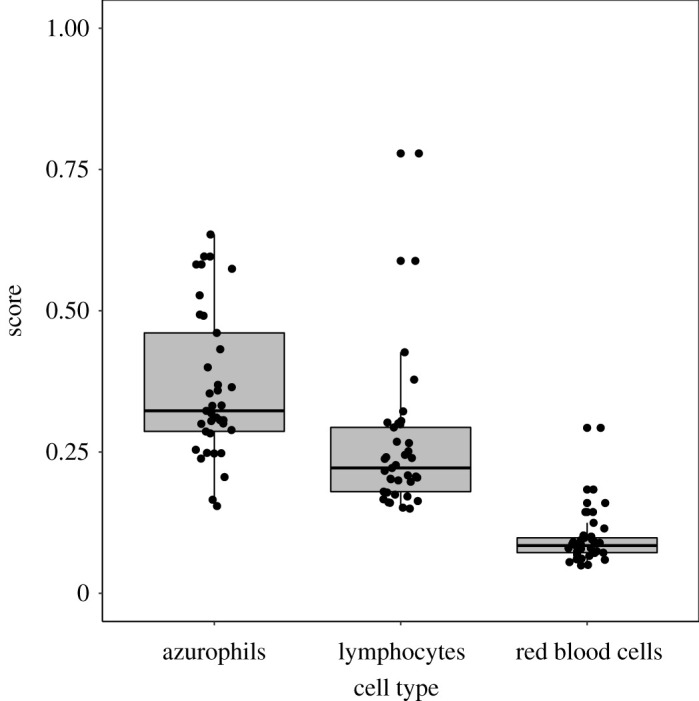
Box plot of rank sums of telomere lengths for azurophils, lymphocytes, and red blood cells from Ctenophorus pictus. The Wilcoxon scores are significantly different among groups (X2 = 76.9, p < 0.0001, n = 37 for each cell sample).